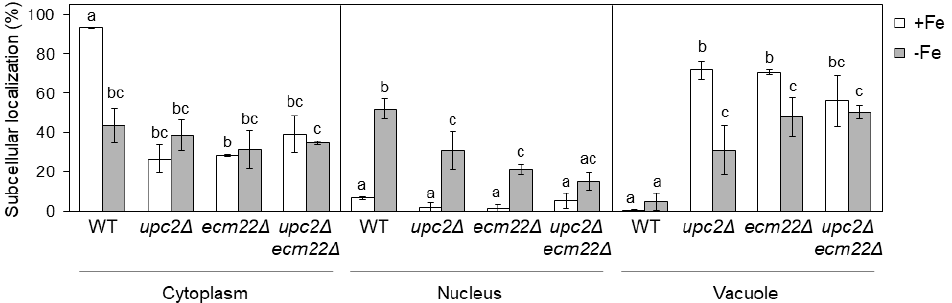
Figure 7. Upc2 and Ecm22 are necessary for the correct localization of Aft1 protein. Quantitative analysis of Aft1 subcellular localization patterns in wild-type (WT, W303), upc2 ∆ , ecm22 ∆ , and upc2 ∆ ecm22 ∆ cells containing JK1346 (pRS426-GFP-AFT1) plasmid. Cells were cultivated as indicated in Figure 6 and visualized under Nomarski (DIC) and GFP fluorescence optics. More than 100 cells were counted for at least three different experiments. GFP-Aft1 distribution patterns were considered as cytoplasmic, nuclear or vacuolar. Average and SD were represented. Statistical analysis has been performed independently for cytoplasm, nucleus, and vacuole, and different letters above bars of each panel indicate significant differences ( p -value < 0.01).